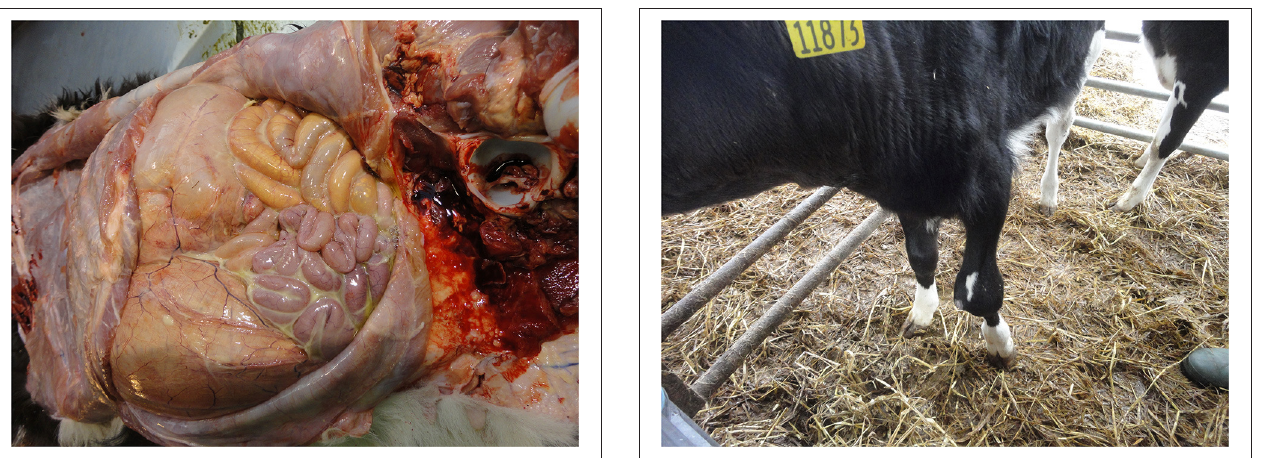
FIGURE 14 | Joint ill causing swelling of the carpus in a young calf.